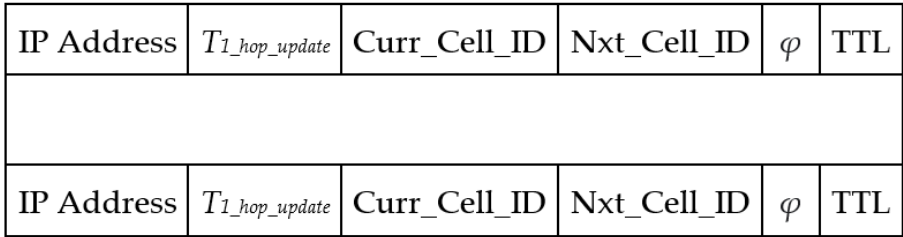
Figure 3. Data table format for storing the list of one-hop neighbors.